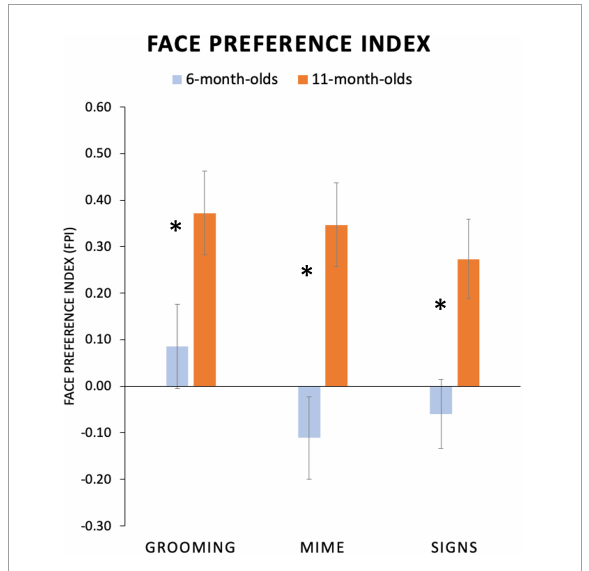
FIGURE5 Average face preference index (FPI) values for each age group and condition. FPI values are plotted on the y- axis, with positive values indicating greater attention devoted to the face than the torso area and negative values indicating the opposite preference. Six-month-old infants attended to the face for Grooming body actions and to the torso region for both Mimes and Signs. Eleven-month-old infants showed an evenly high face preferences for all conditions. (Standard error bars plotted ∗ , p <